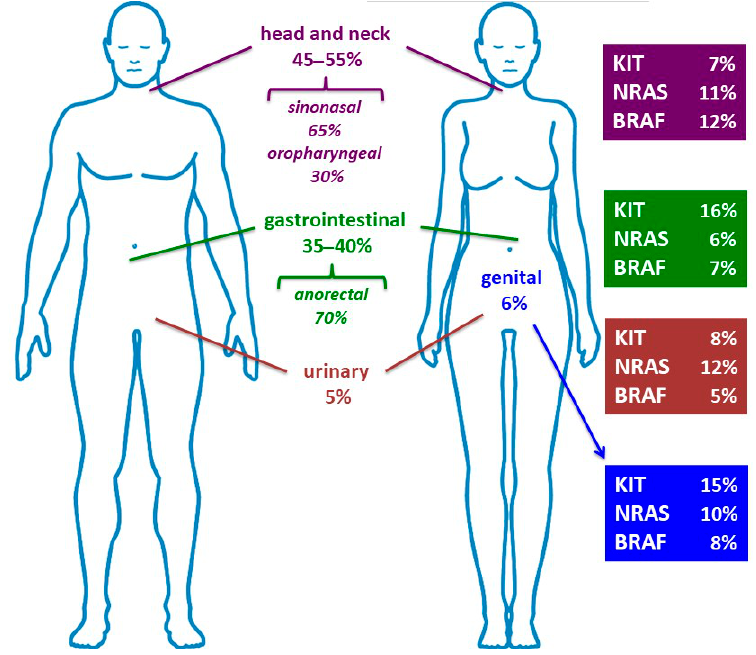
Figure 2. Distribution of MM anatomical locations (head and neck, gastrointestinal, urinary, and genital) and correspondent mutation frequencies for the main driver oncogenes (BRAF, NRAS, and KIT). Mutation prevalence values were mainly derived by NGS-based approaches (for references, see text).